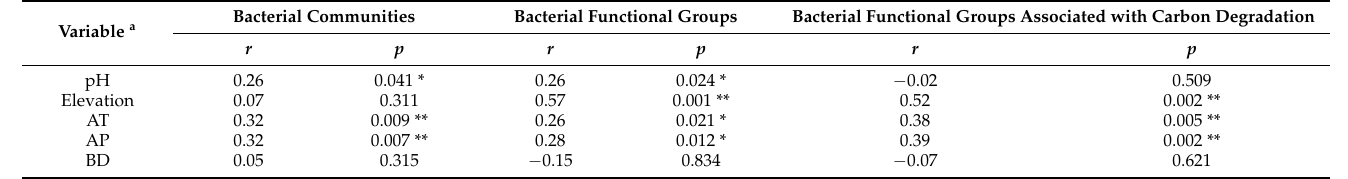
Table 2. The influence of environmental factors on bacterial communities and bacterial functional groups as determined by partial Mantel